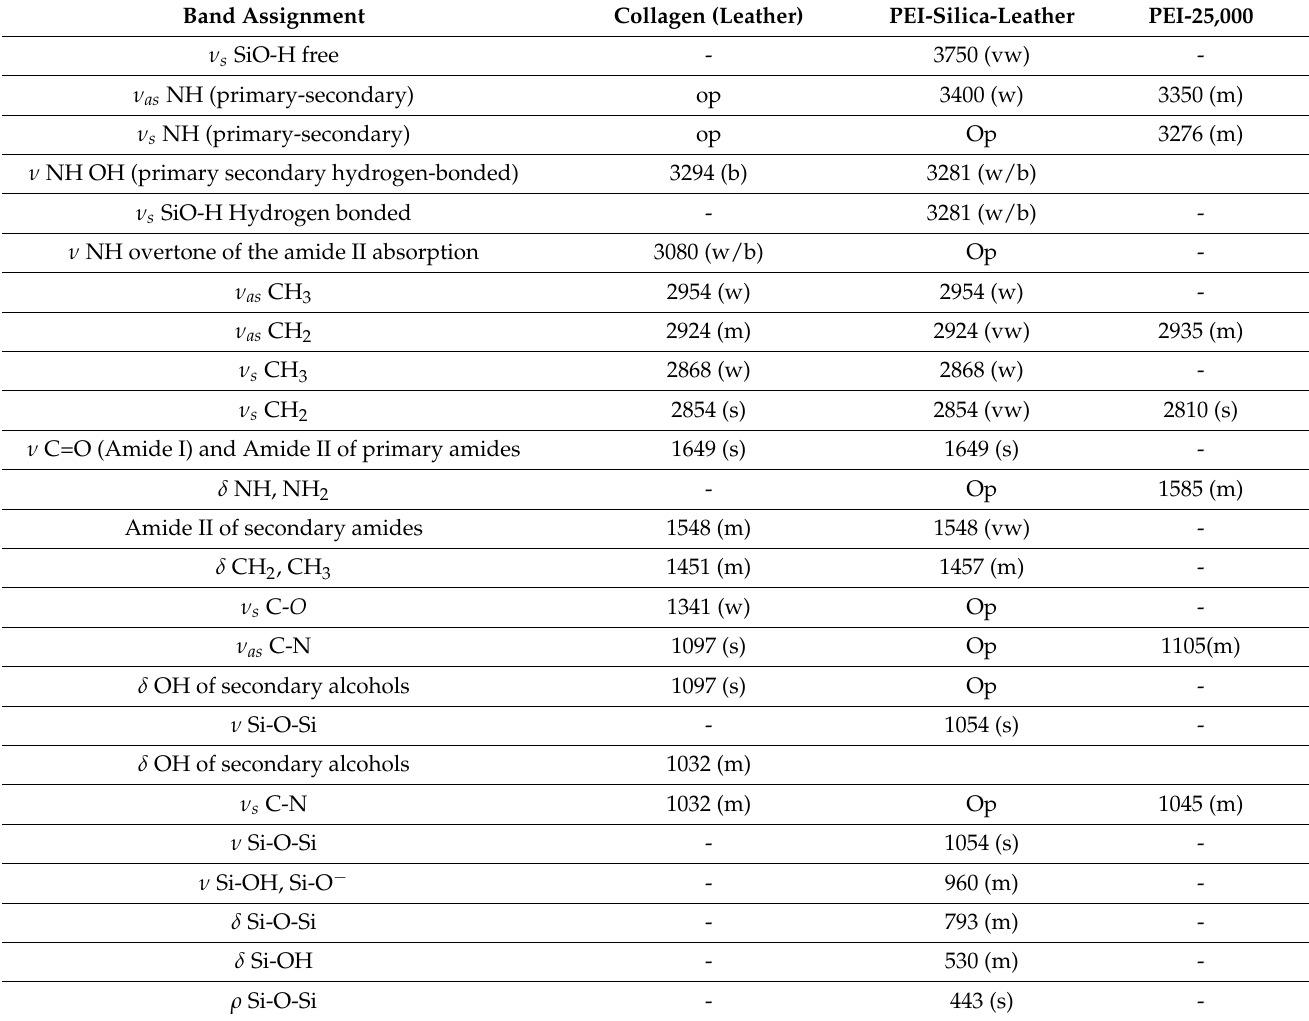
Table 1. Assignment of the IR absorption bands of the uncoated leather; leather treated by silica-PEI 25,000-Ag Nps and the hyperbranched poly(ethyleneimine) PEI 25,000 (Mw 25,000). Band